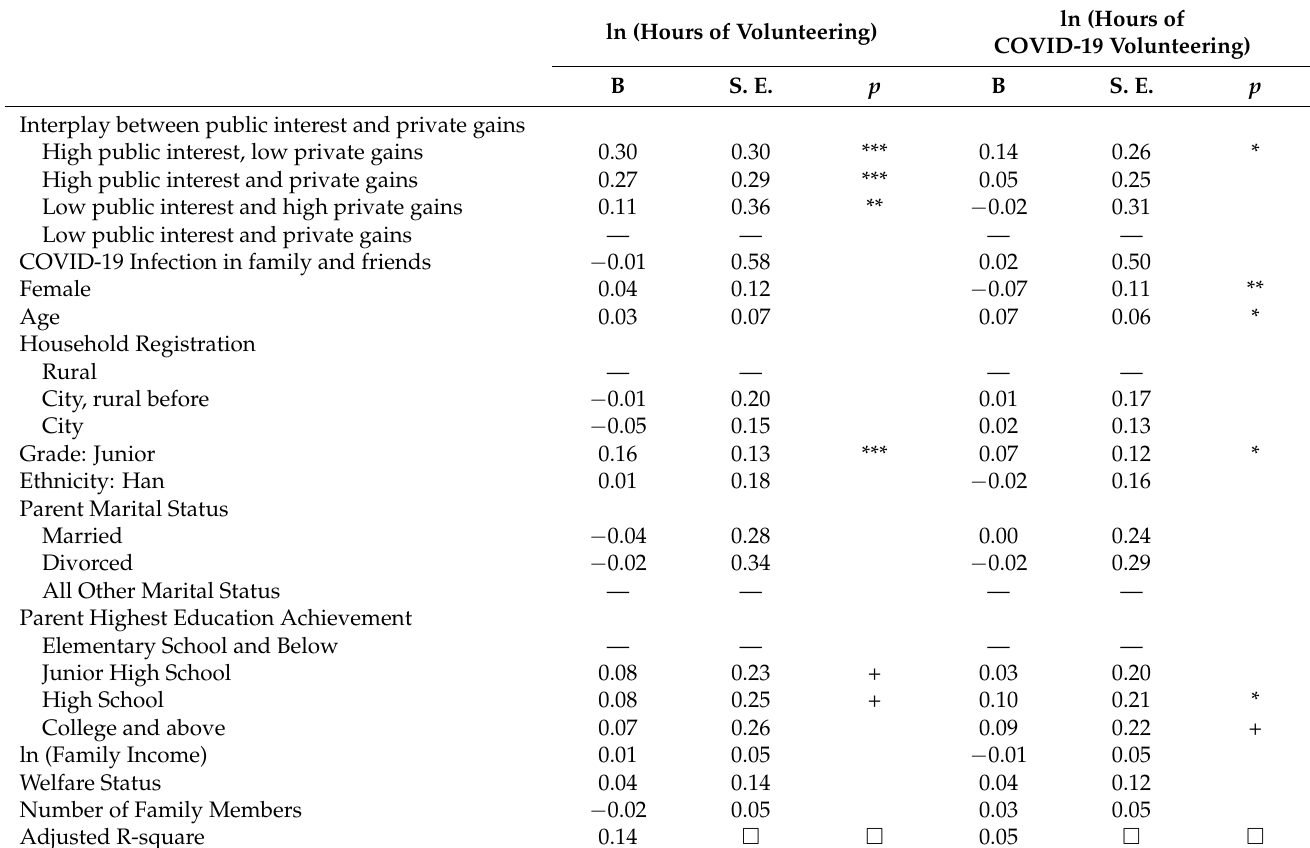
Table 4. OLS Regression of Hours of